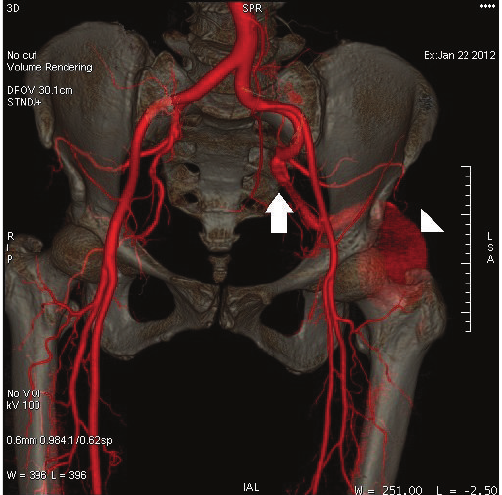
Figure 2: CT angiogram. The arrow depicts the abnormally large internal iliac artery. The arrowhead depicts the aneurysmal dilata- tion. Note the normal-sized internal iliac artery of the opposite side.